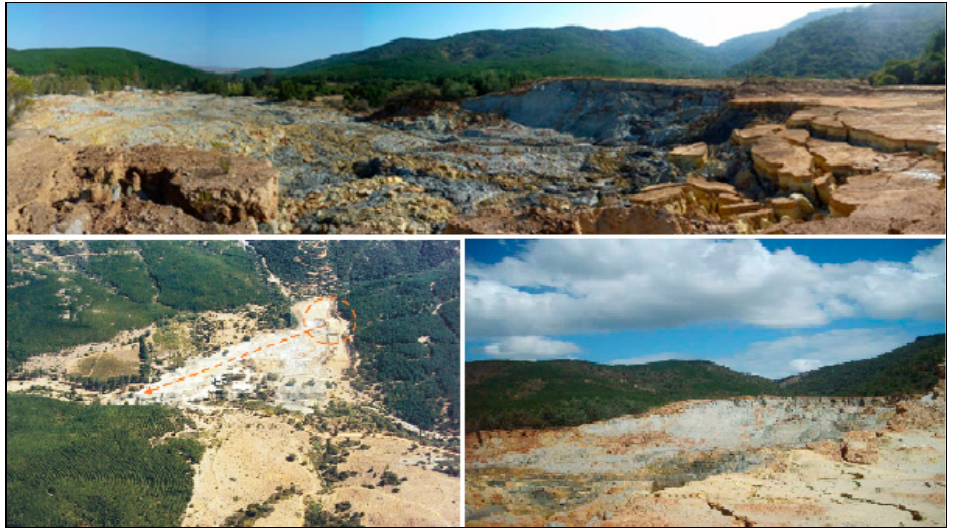
Figure 14. Collapsed area of Las Palmas tailings storage facility